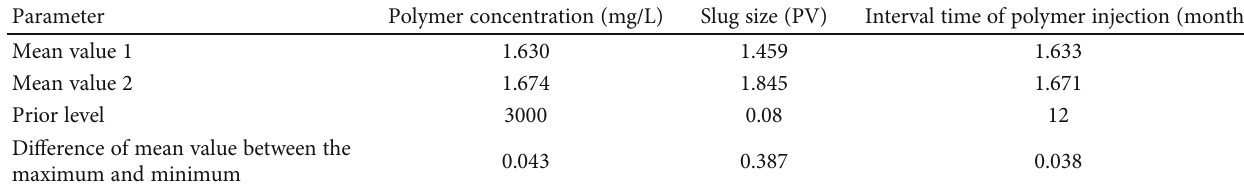
Table 4: Intuitive analysis table of B6 well group.